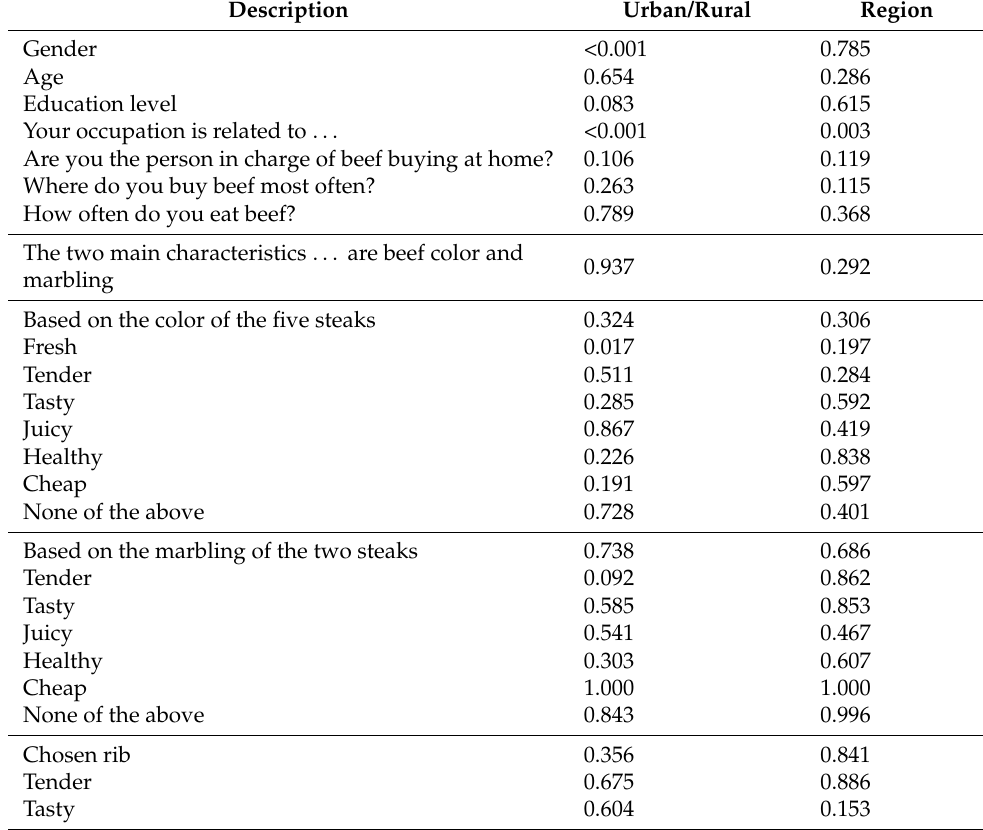
Table 3. Chi-square p -values for the Kruskal–Wallis test, with urban/rural or region criteria as the main